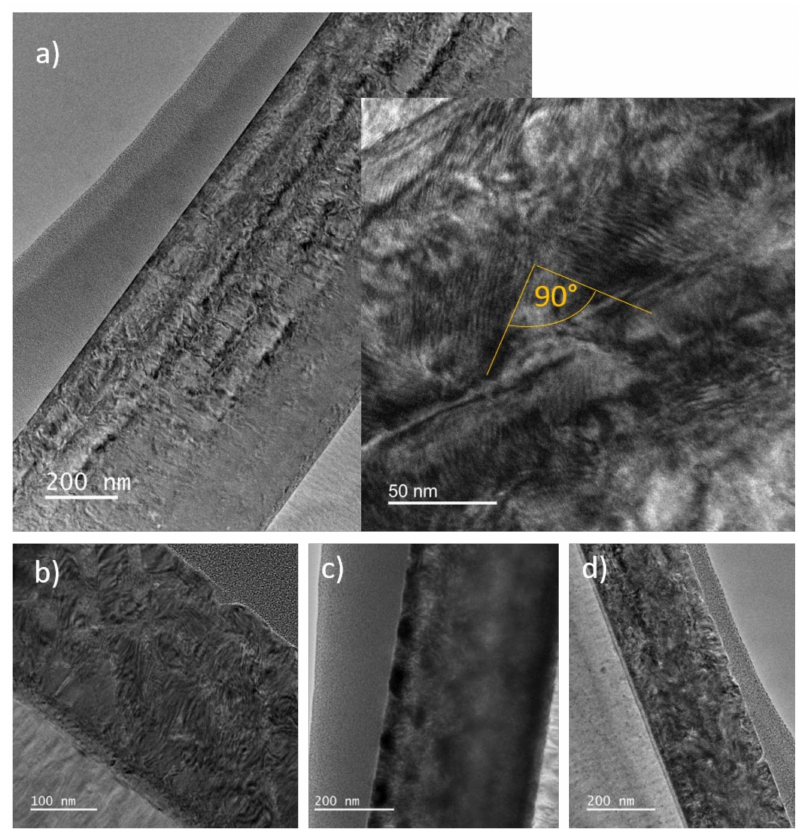
Figure 8. ( a ) A checkerboard pattern is not clearly visible in the survey TEM image of the MI7- 30/100 sample. The inset contains a close up. Moir é patterns, which are tilted by 90 ◦ to each other, are slightly visible. TEM images of the MI6-30/30 sample ( b ) and MI6-30/50 sample ( c ) showing